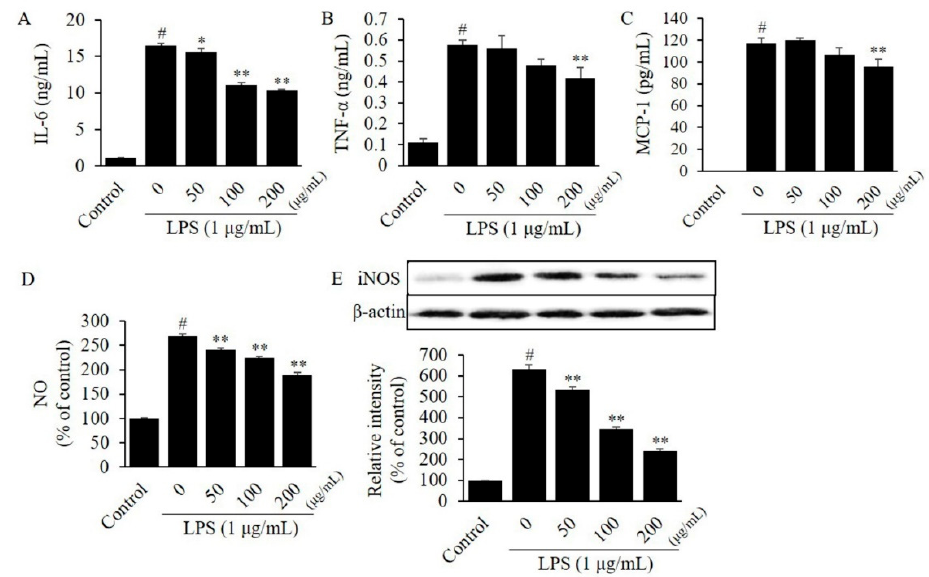
Figure 5. Effect of CTFV on the inflammatory response induced by 24 h co-culture using the contact method. The levels of IL-6 ( A ), TNF- α ( B ), MCP-1 ( C ), NO ( D ), and iNOS ( E ) in the medium co-cultured with RAW264.7 and 3T3-L1 were measured by ELISA, the Griess reagent, and western blot analysis. Measurement of these expression or levels in the non-treated co-culture medium was used as the control group. Each value is the mean ± SD of triplicate measurements. # p < 0.01, compared with non-treated co-culture medium group. * p < 0.05 and ** p < 0.01, compared with only LPS-treated co-culture medium group. CTFV, C. tricuspidata fruits vinegar; IL, interleukin; TNF, tumour necrosis factor; MCP, monocyte chemoattractant protein; NO, nitric oxide; iNOS, inducible nitric oxide synthase; ELISA, enzyme-linked immunosorbent assay; LPS, lipopolysaccharide.